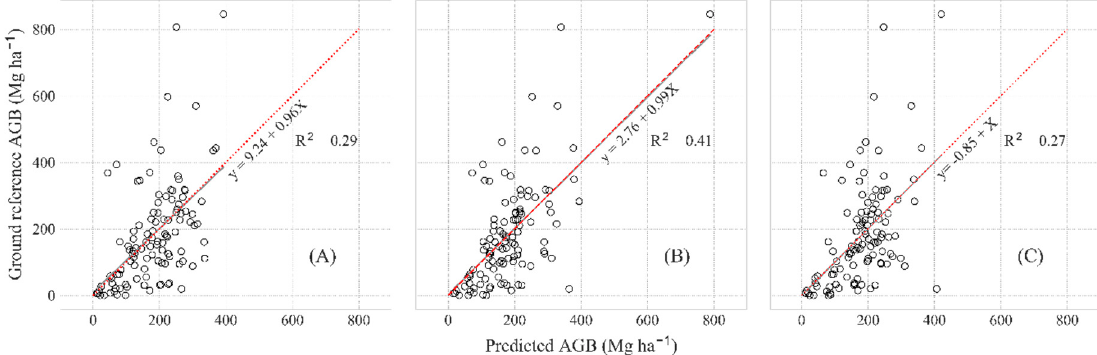
Figure 3. Relationship of ground reference versus predicted AGB using selected models of ( A ) L8, ( B ) S2, and ( C ) PS data. The dashed red and grey solid lines (overlapping) represent the identity (1:1) and the correlation functions, respectively.